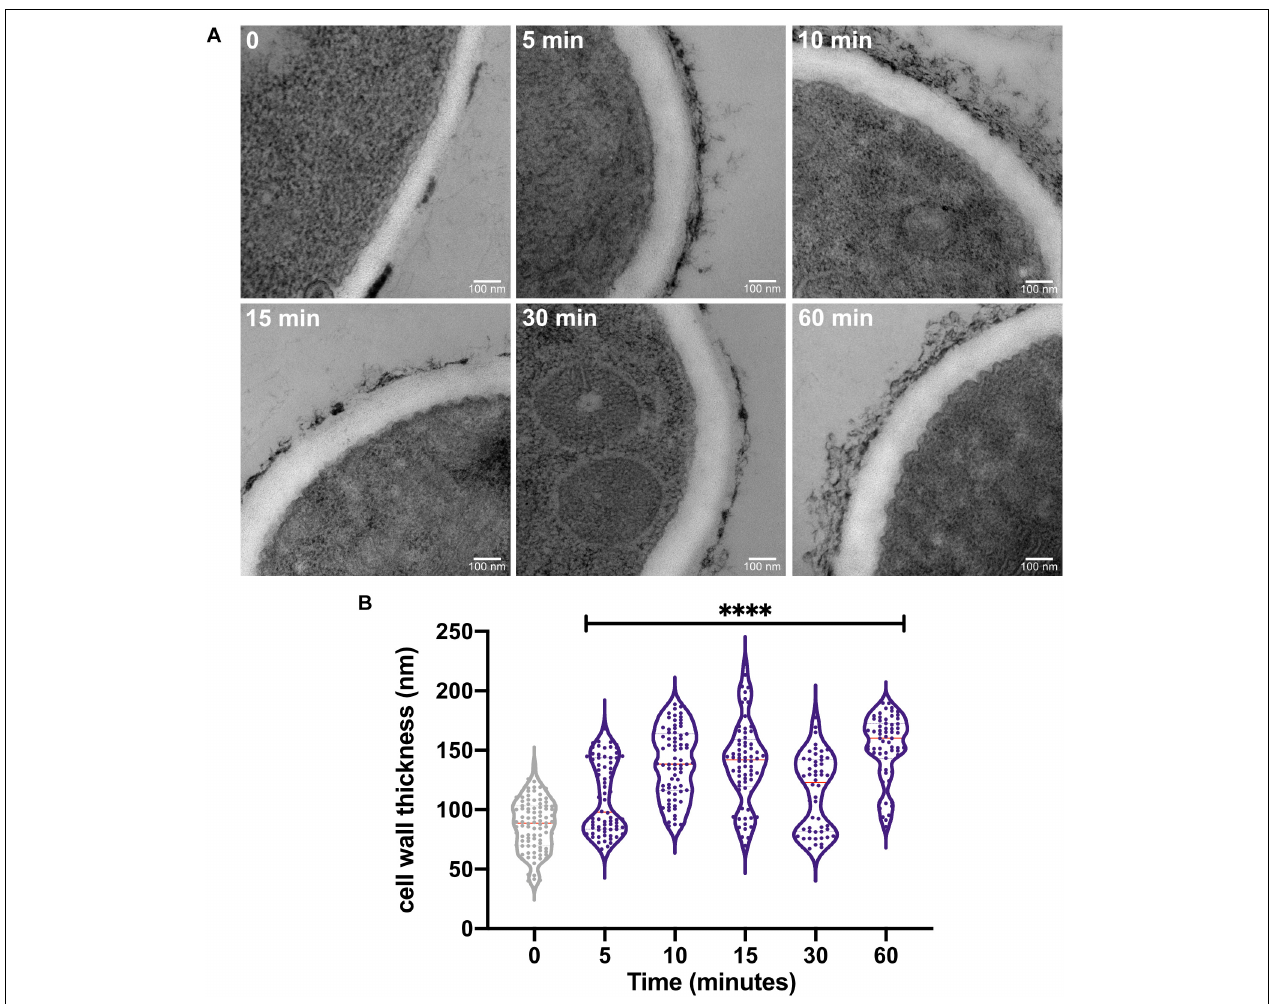
FIGURE 1 | The heat shock stress causes an increase in the cell wall thickness of A. fumigatus . (A) The A. fumigatus wild-type strain was statically grown in complete liquid media for 36 h at 30 ◦ C, heat-shocked at 48 ◦ C for the indicated times, and prepared for transmission electron microscopy analysis. (B) Cell wall thickness measurement of the germlings shown in violin plot of 50 sections of different germlings. Dashed lines indicate the quartiles and red lines indicate the median for each point. ∗∗∗∗ p ≤ 0.0001 (one-way ANOVA and Dunnett’s multiple comparisons